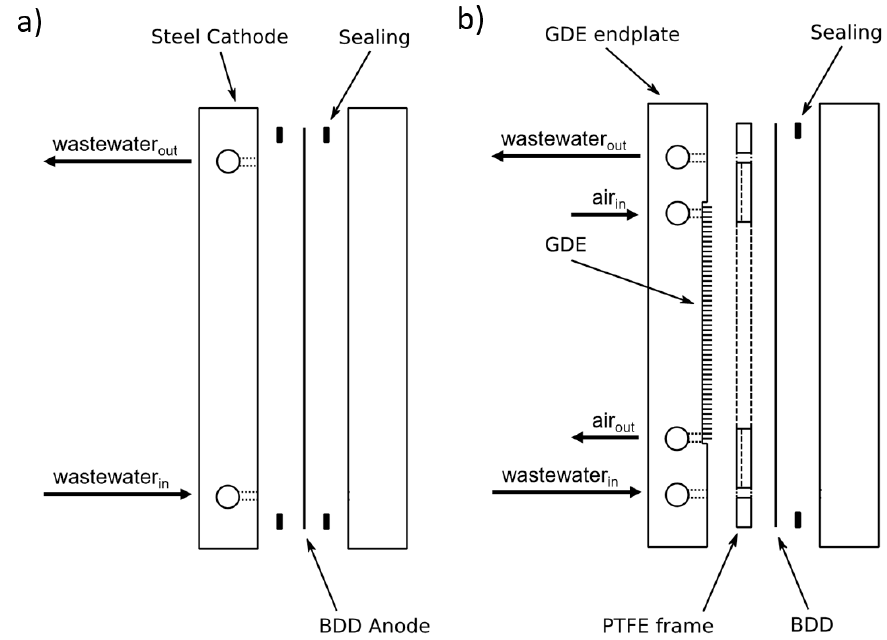
Figure 2. The investigated boron-doped diamond-based electrolysis cells with ( a ) a steel cathode and an active electrode area of 82.6 cm 2 . ( b ) A gas diffusion electrode integrated into a steel body with an active electrode area of 41.3 cm 2 . A sealing with a PTFE frame was used to ensure similar electrode distances of 2 mm. The process streams are sketched. For more details see the Figures S3 and S4 in the Supplementary Information.